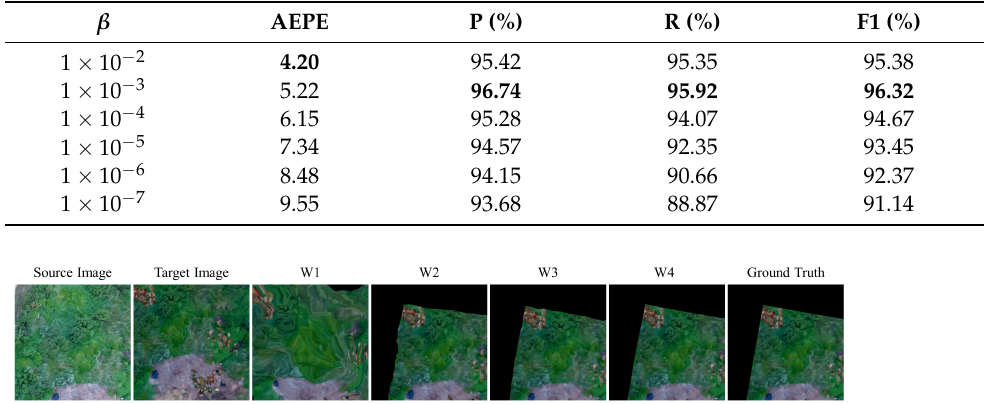
Figure 10. The registration results in β = 1 × 10 − 3 . W i denotes different optical flow pyramid levels.